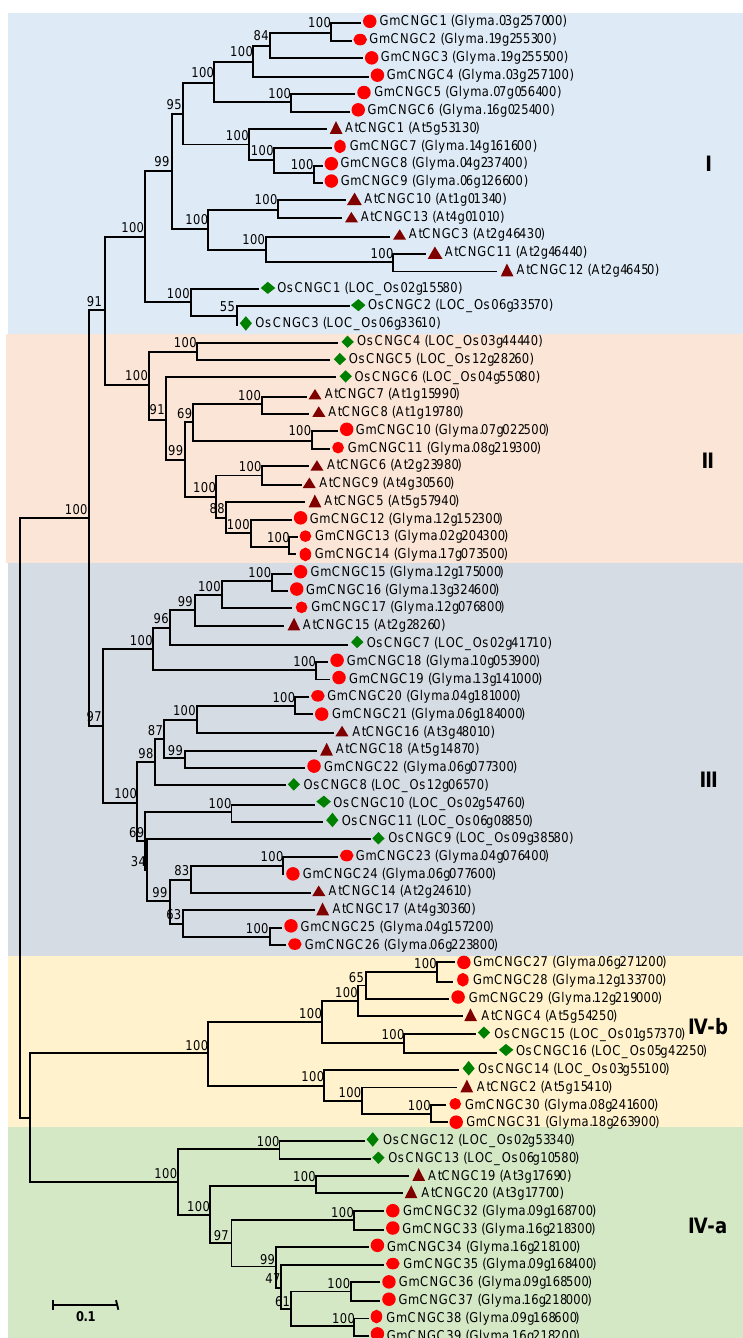
Figure 2. Unrooted phylogenetic tree of the cyclic nucleotide-gated ion channel (CNGC) family proteins from soybean ( Glycine max ), rice ( Oryza sativa ), and Arabidopsis thaliana . The alignment for the phylogenetic tree was performed with ClustalW using full-length amino acid sequences. The phylogenetic tree was created with the MEGA6 software and the neighbor-joining method with 1000 bootstrap replications. GmCNGCs are marked with red circles, AtCNGCs were marked with purple triangles, while OsCNGCs were marked with green diamonds. The locus name of each gene is shown in brackets. The bar indicates the relative divergence of the sequences examined, and bootstrap values are displayed next to the branch. Roman numerals designate the subfamilies.